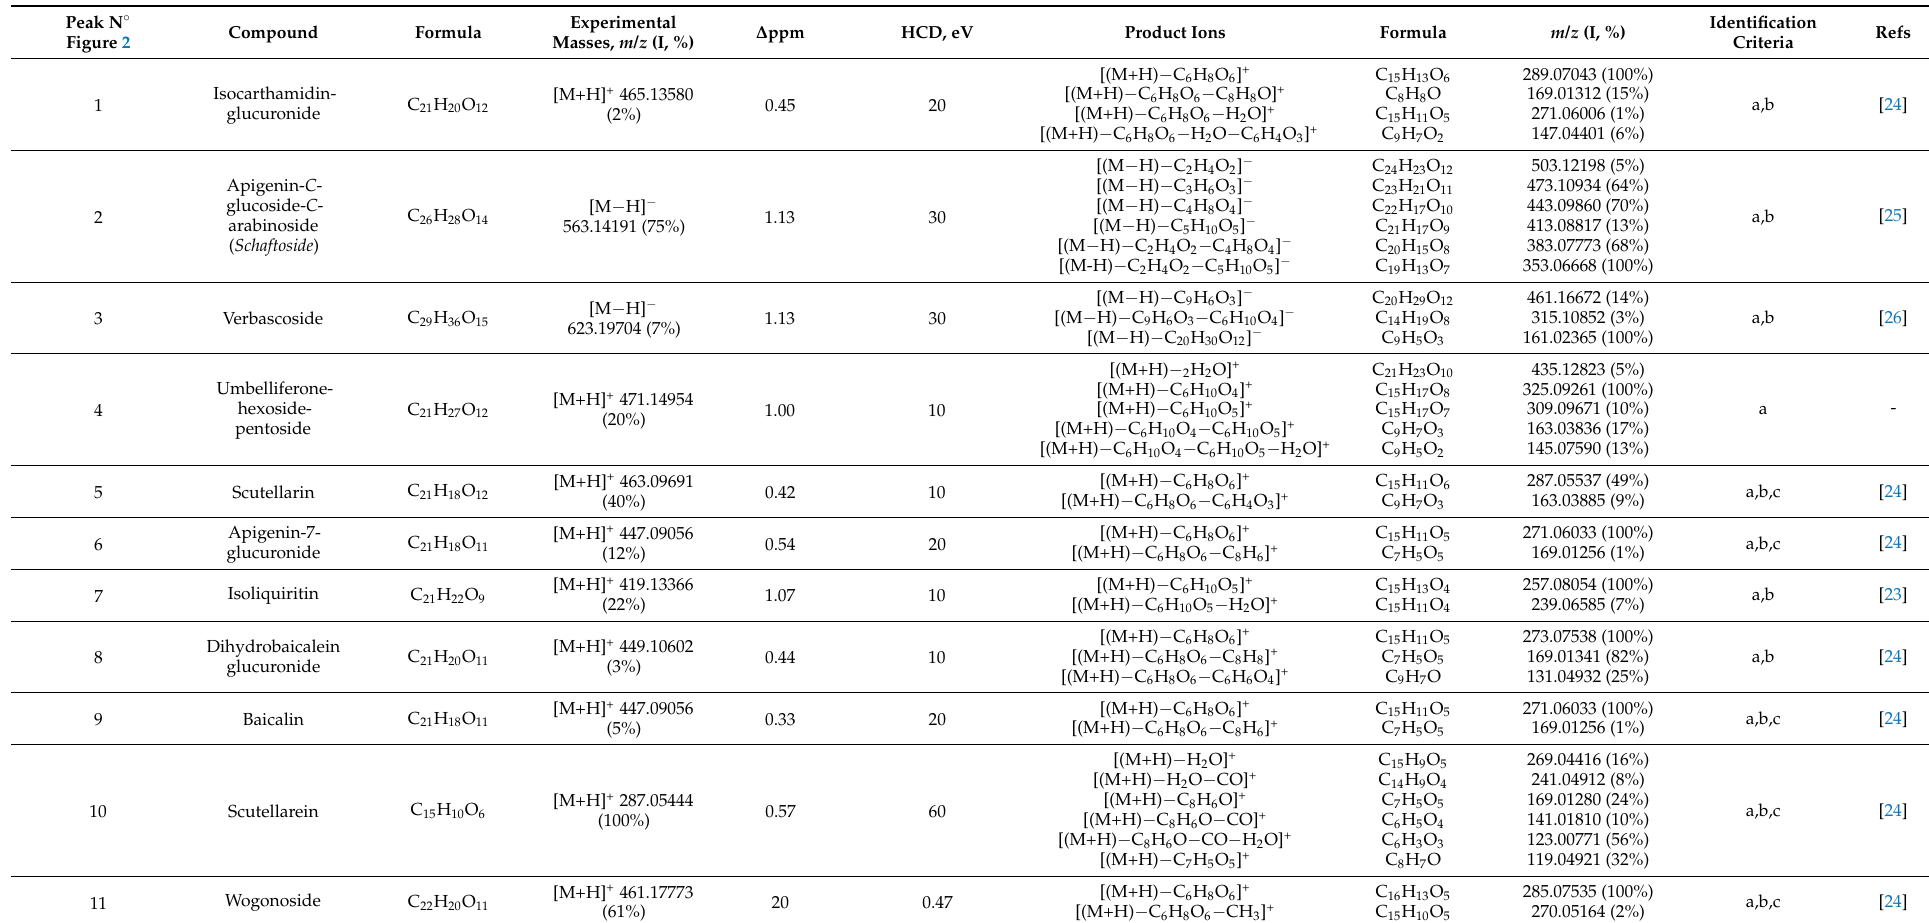
Table 3. Exact masses obtained by UHPLC/ESI-Q- Orbitrap -MS of protonated [M+H] + and deprotonated [M − H] − molecules and product ions of phenolic compounds present in Scutellaria spp.